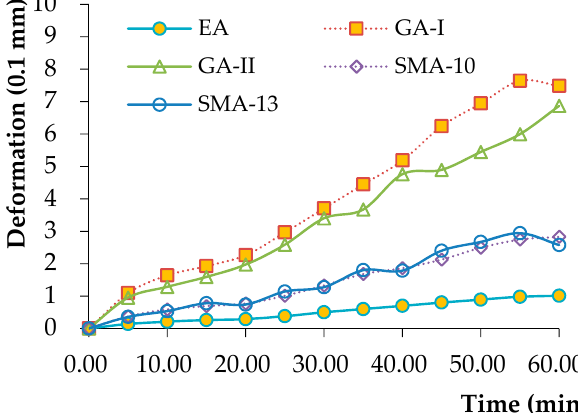
Figure 2. Rutting test results for asphalt concretes at 70 °C.